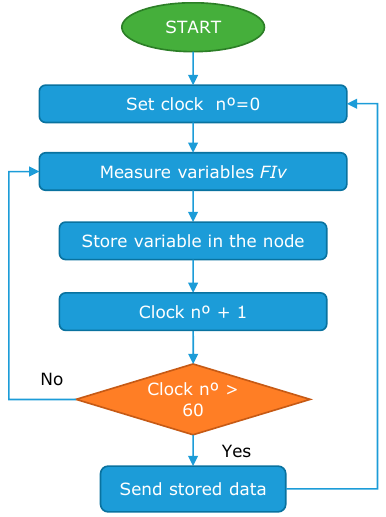
Figure 4. Operation algorithm for fish behavior algorithm.